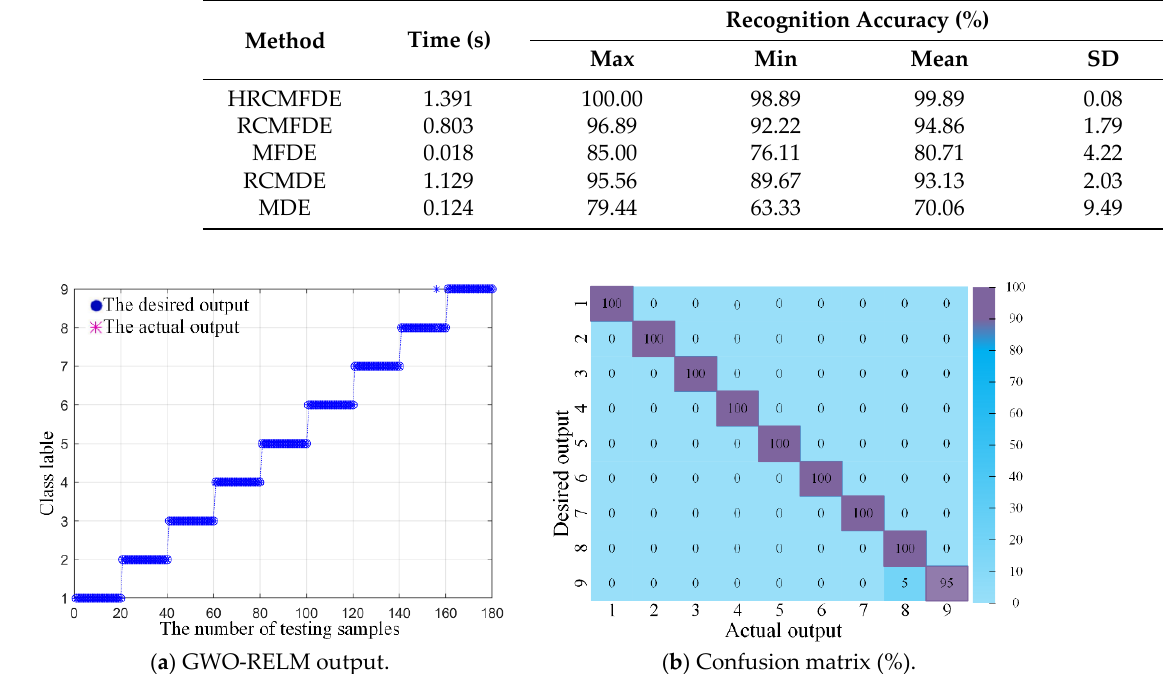
Figure 23. Identification results of the proposed method. Table 13. The performance comparison between different methods.